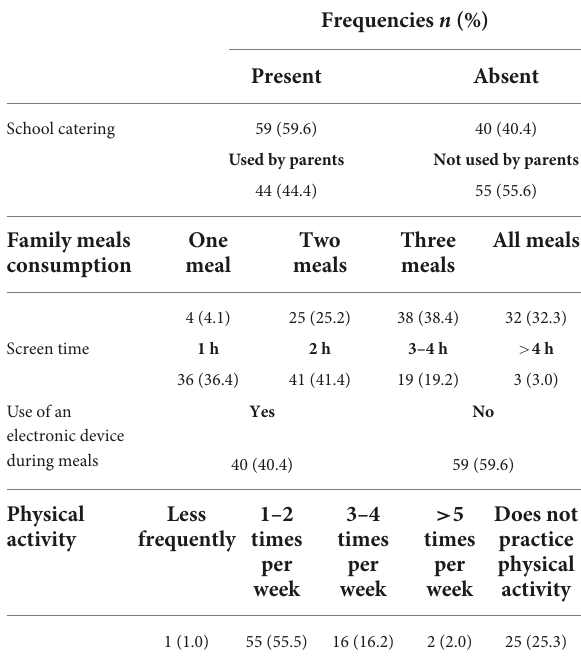
TABLE 3 Eating and lifestyles habits in the pre-pandemic